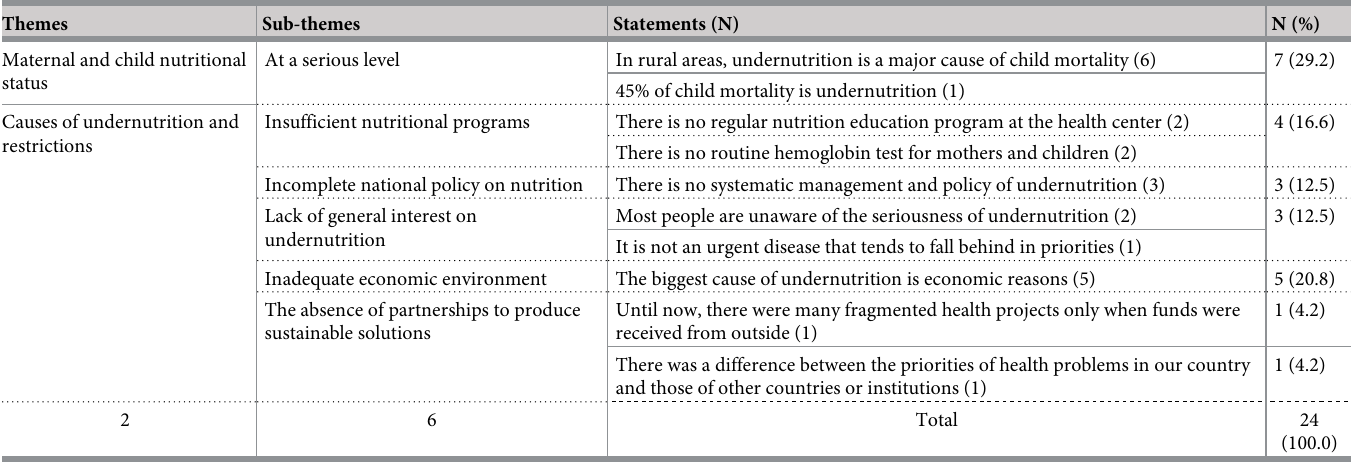
Table 6. Content analysis of semistructured interviews with